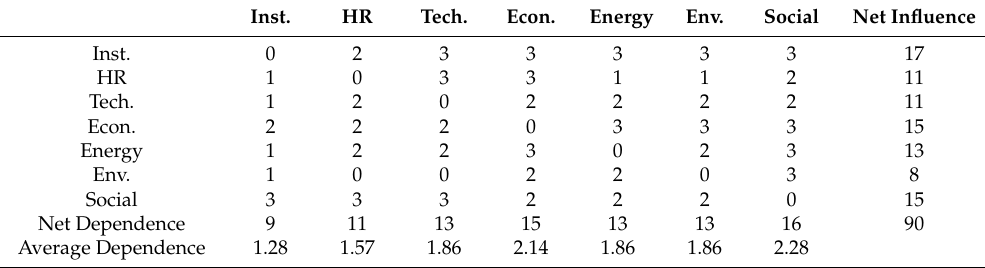
Table 4. Cross-impact analysis among the seven categories of capacity. Inst.: